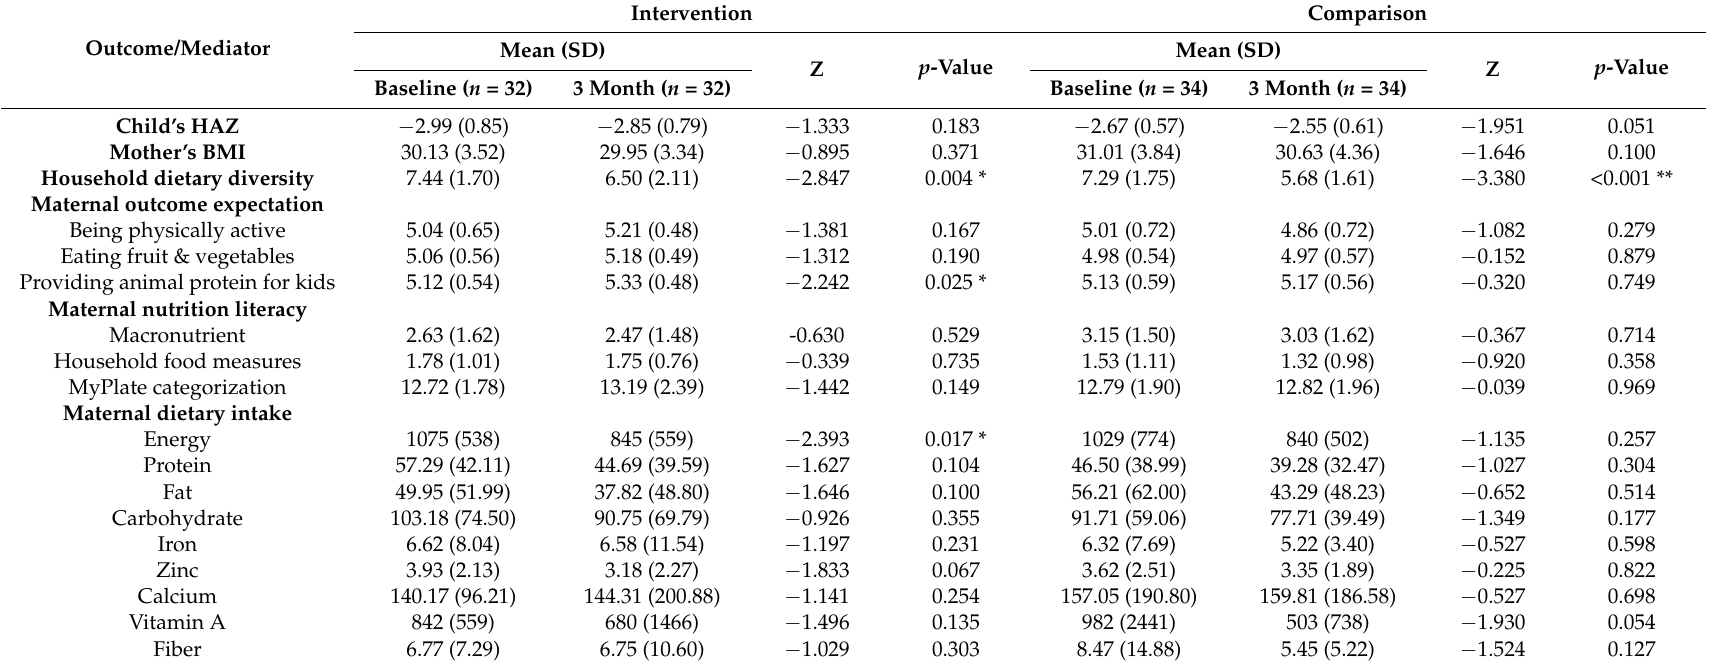
Table 4. Group means and differences between group means for all outcomes in non-parametric statistics ( n = 66).